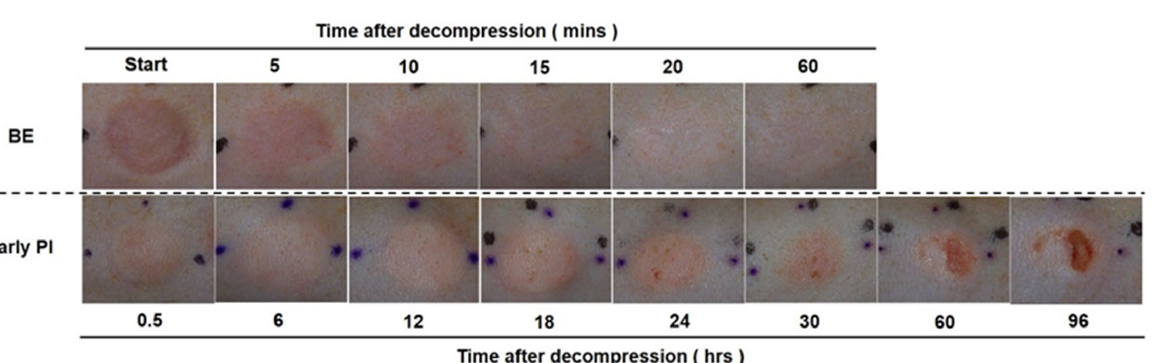
6 of 10 Figure 4. Images of pathological observation and quantification of thrombi: ( A ) the parts with ink perfusion showed post ‐ mortem blood clots. On the other hand, the parts without ink perfusion in the small artery showed thrombus formation post ‐ decompression in the early PI group, which